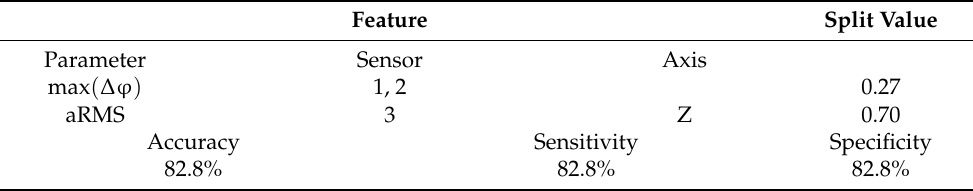
Table 6. Split Values, Accuracy, Sensitivity and Specificity for Rowing Decision Tree calculated according to